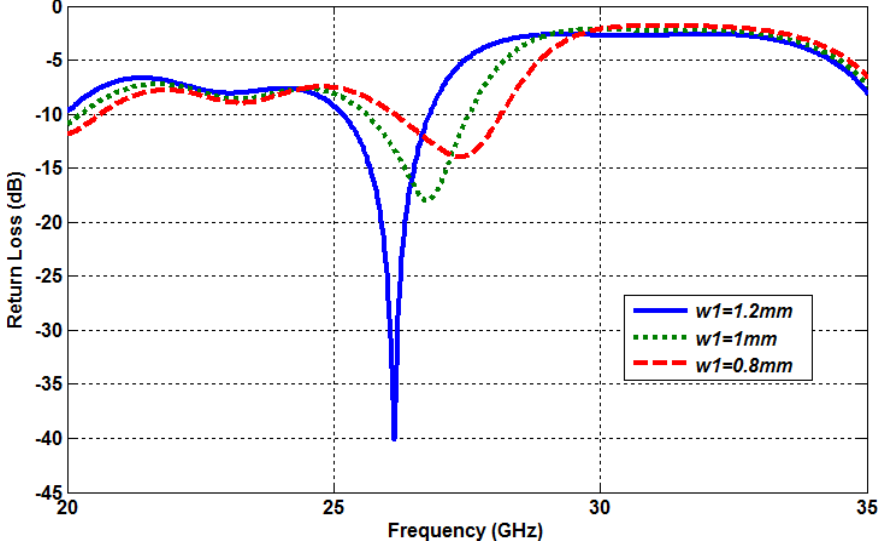
Figure 2. Antenna performance with the variations in term w1.